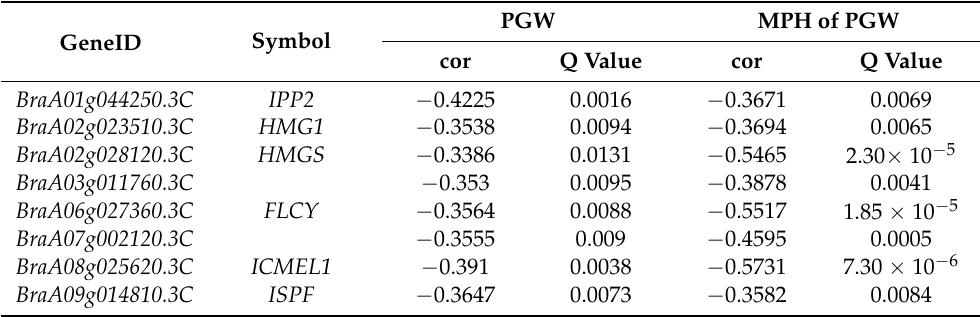
Table 8. Correlation between hybrid PGW and parental gene expression levels in terpenoid main chain